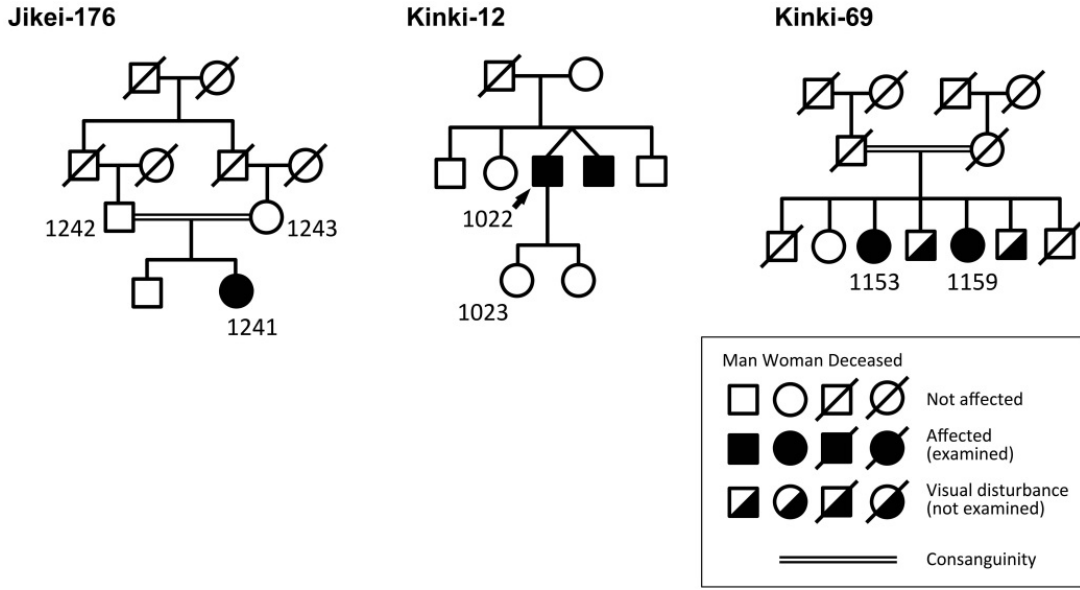
Figure 2. Pedigrees for the segregation analysis.